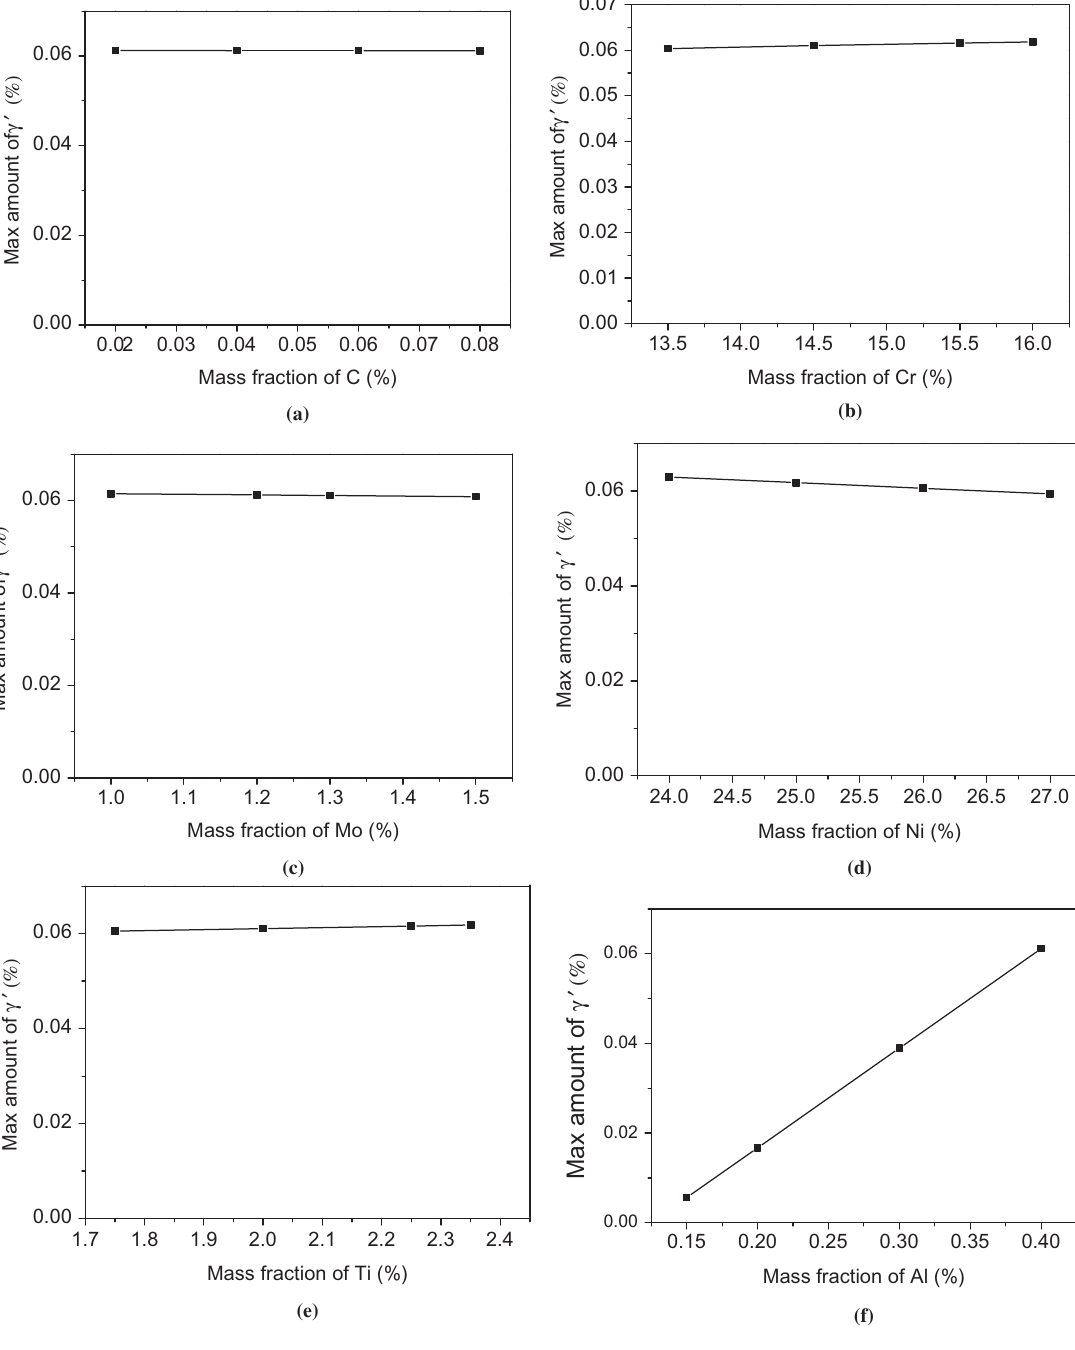
Figure 7. The variation of C, Cr, Mo, and Ni contents have the positive correlation with precipitation temperature of M C phase. However, the variation of Ti and Al contents 23 6 has the negative influence on the precipitation tempera- ture of M C phase. 23 6